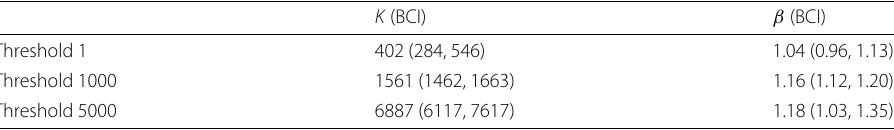
Table 1 Power law regression